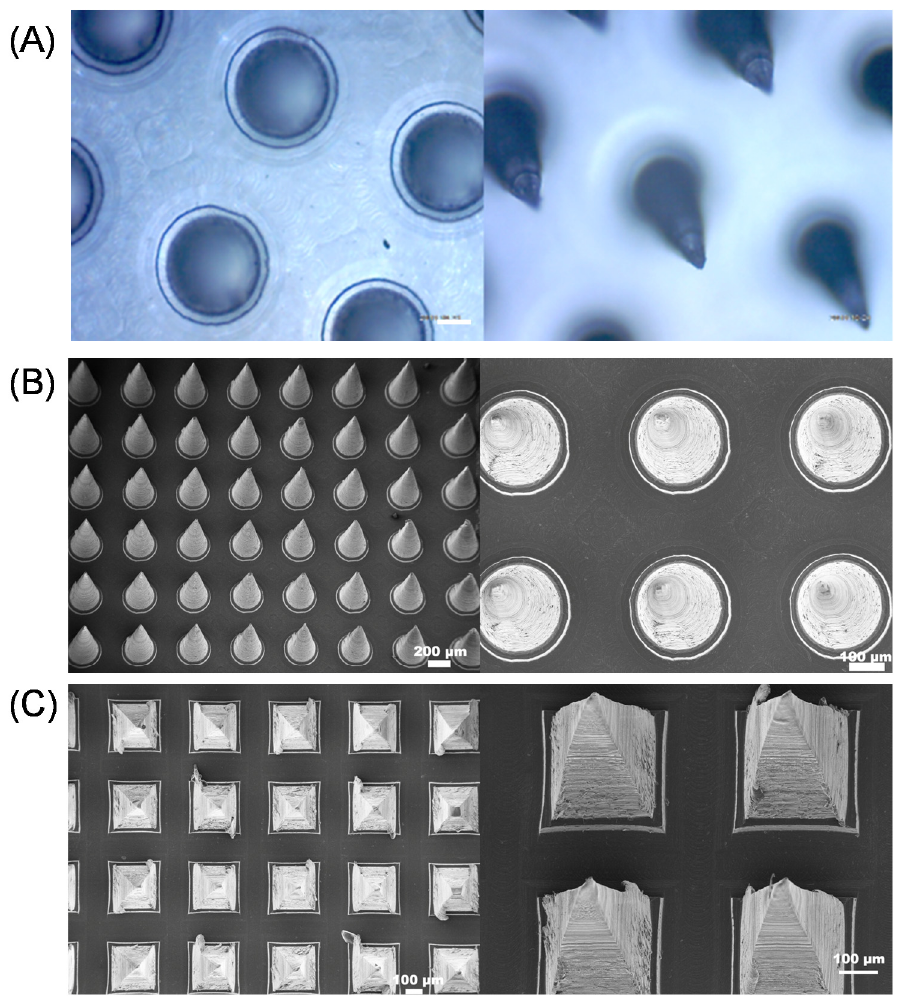
Figure 3. ( A ) Top view under an optical microscope (scale bar: 100 μ m) (left) and side view under optical microscope (right); ( B ) scanning electron microscopy (SEM) images of cone MN; ( C ) SEM images of pyramid MN.